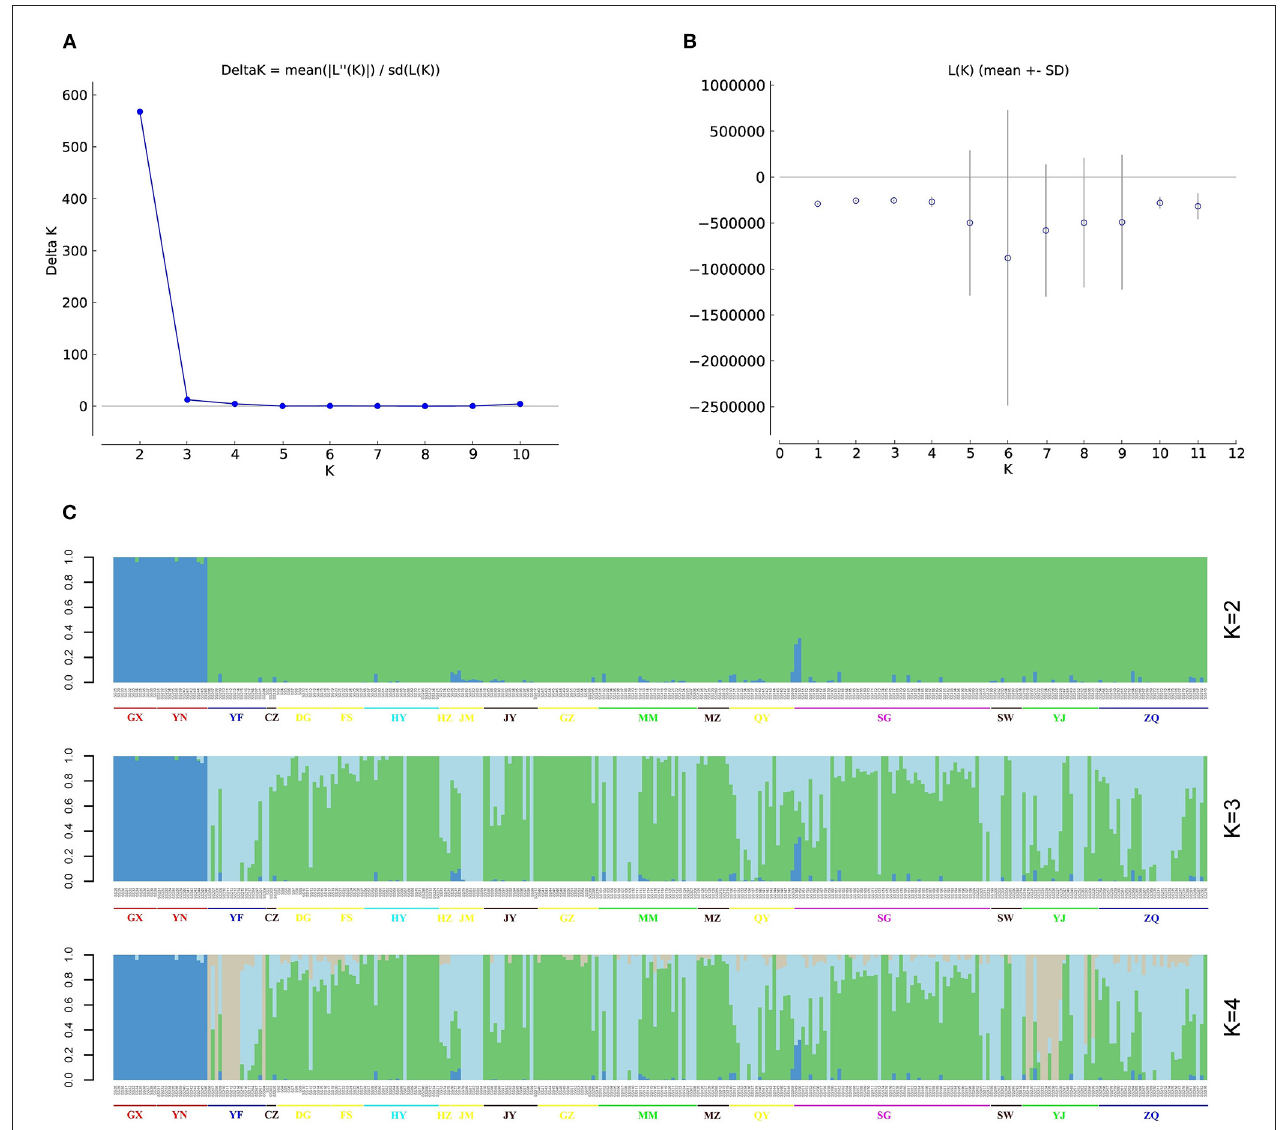
FIGURE 3 | Population structure of 302 S. superba accessions. (A) Delta K values for different numbers of clusters ( K = 1–10) using Structure v2.3.4, the Delta value was highest at K = 2. (B) Average log-likelihood of each value of K . (C) Population structure of 302 S. superba accessions at K = 2–4.